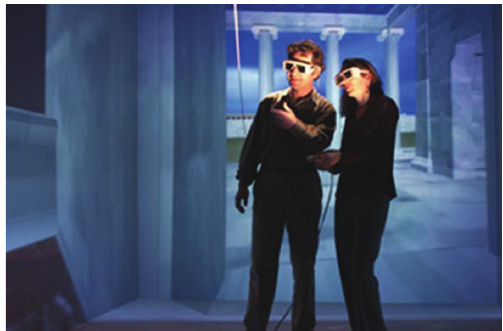
Figure 2: Kivotos project